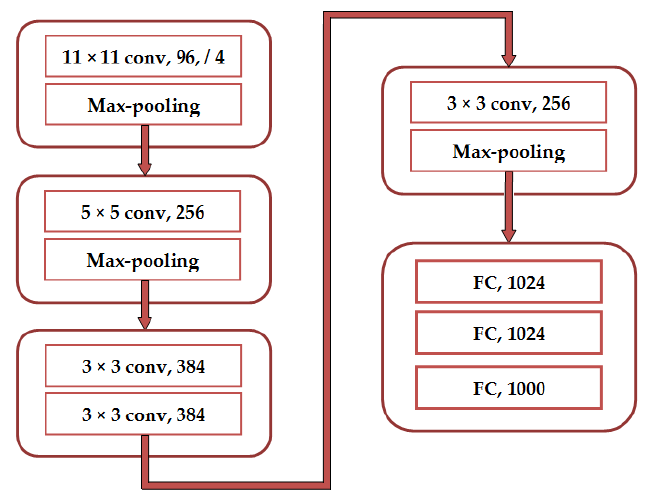
Figure 23. AlexNet architecture. FC (fully connected layer): fully connected layers. conv: convolution.